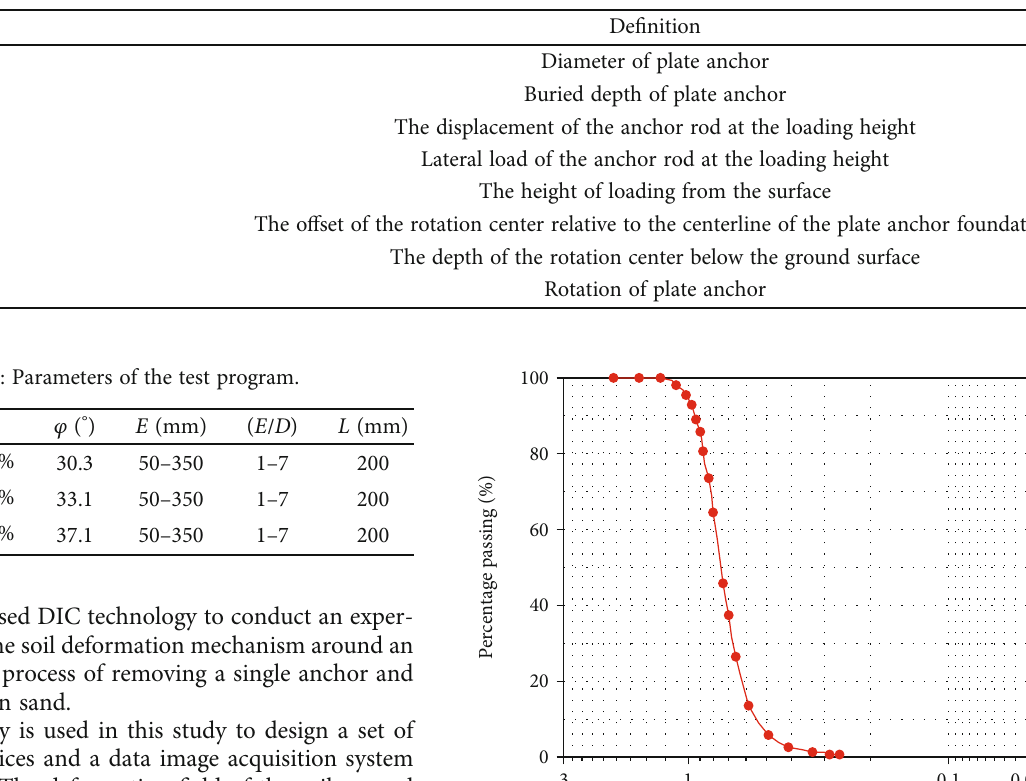
Figure 1: The experimental system. Table 1: The de fi nition of symbols.